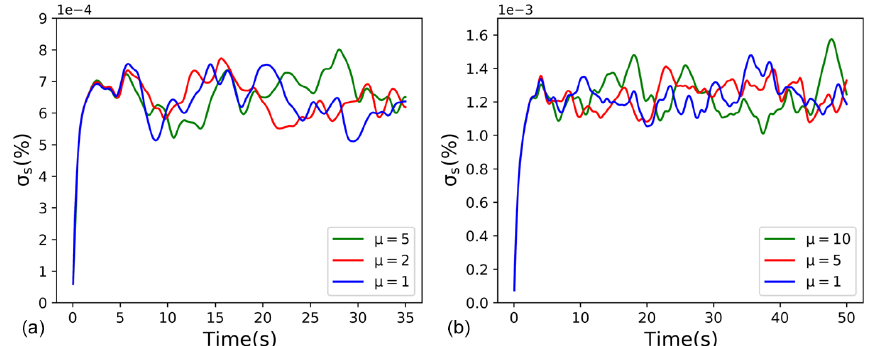
Figure 4. Standard deviation of supersaturation fluctuations for 6 . 4 3 cm 3 real DNS (a) and 12 . 8 3 cm 3 real DNS (b) . Colors represent different multiplicity as marked inside each panel.